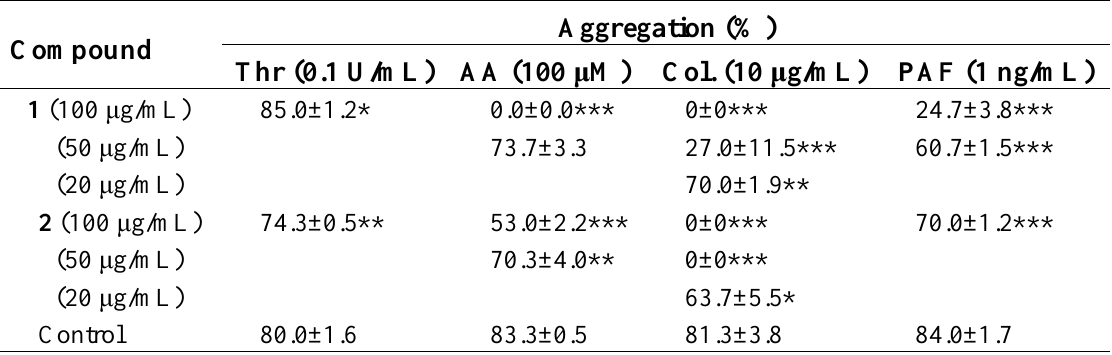
Table 1. Effects of compounds 1 and 2 on the platelet aggregation induced by Thr, AA, collagen, and PAF in washed rabbit platelets. Aggregation (%) Compound Thr (0.1